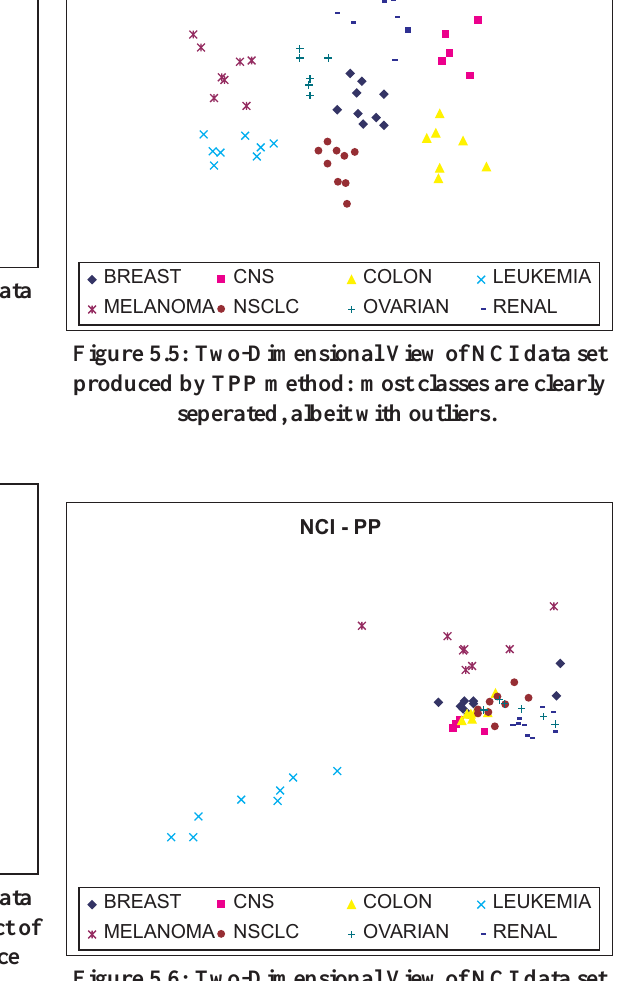
Figure 5.6: Two-Dimensional View of NCI data set produced by PP method: only leukemia and melanoma cases are